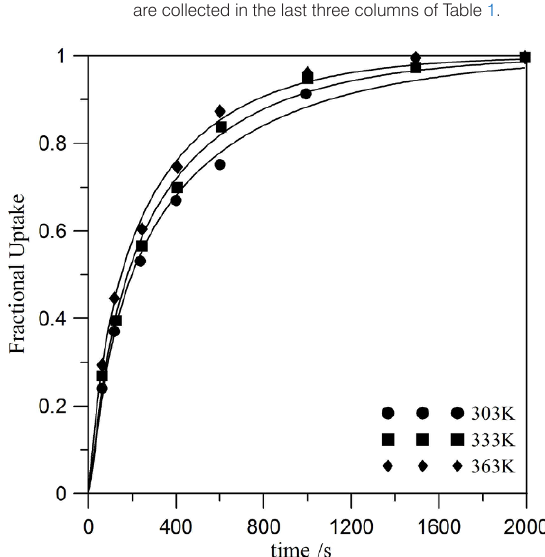
Figure 4. Comparison of the experimental kinetic isotherms for C H /Norit AC adsorption [14] with the theoretical 3 8 predictions (solid lines) by accepting the values of parameters collected in Table